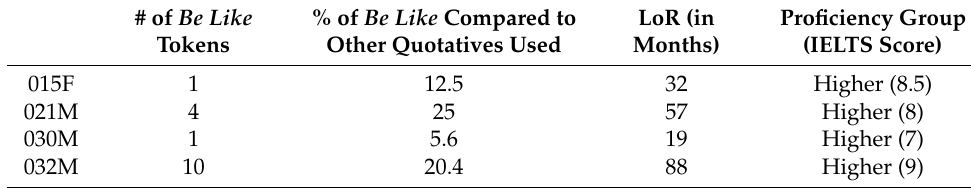
Table 7. Profile of participants who used be like.